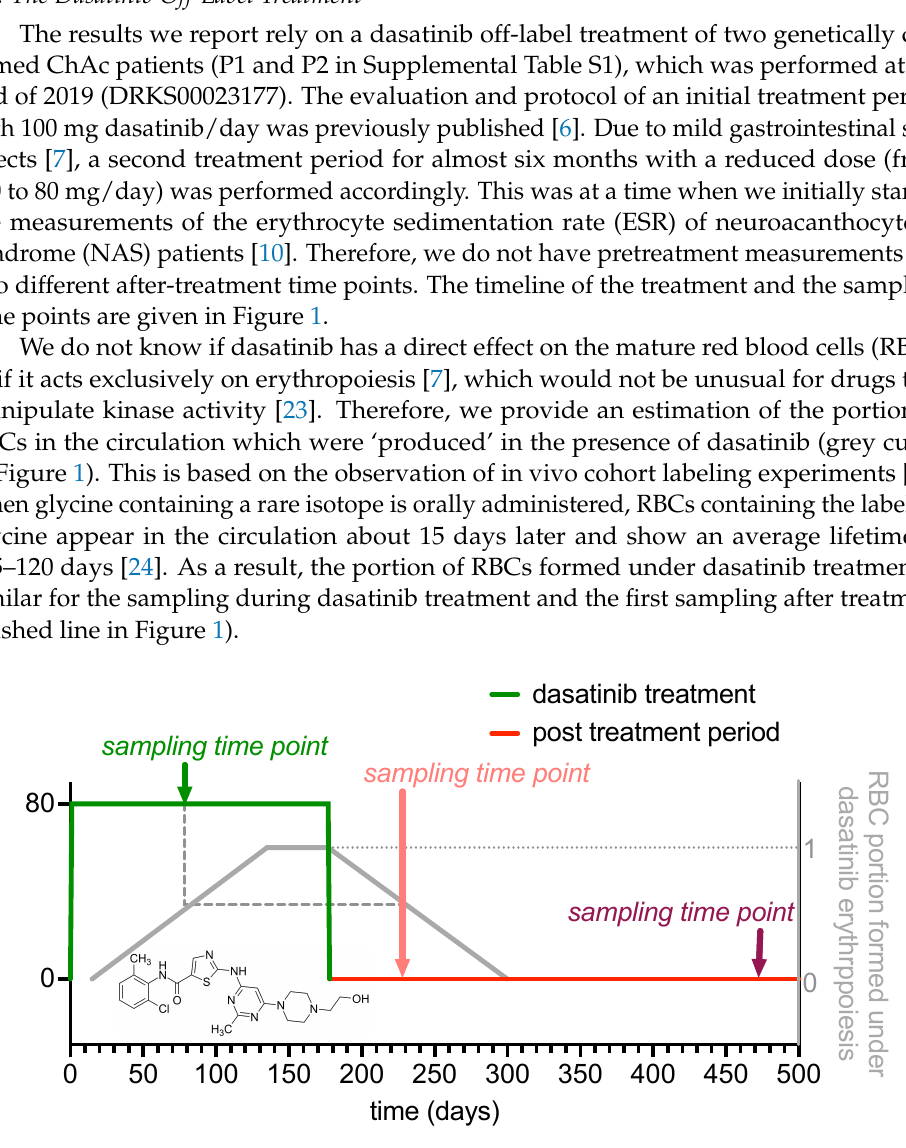
Figure 1. The course of the off-label treatment of two ChAc patients with dasatinib. The diagram depicts the temporal information of the treatment with the sampling time points of the measure- ments performed within this study. The insert shows the structural formula of the Lyn-kinase inhibitor